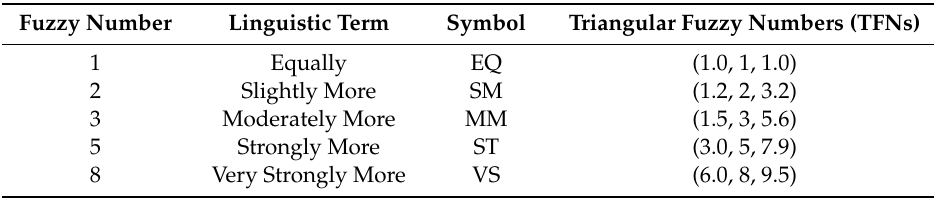
Table 5. The global demand for each product.